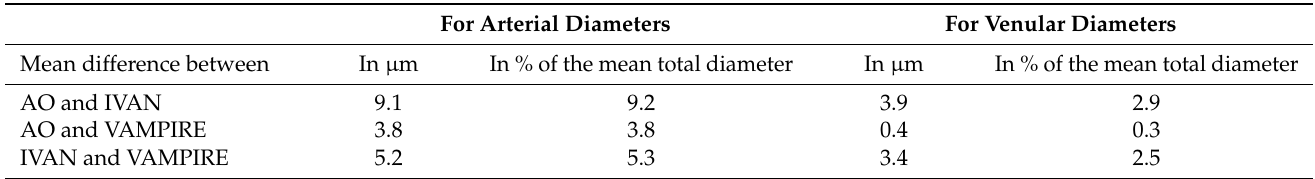
Table 1. Differences between software tools for arteries and for veins. For Arterial Diameters For Venular Diameters Mean difference between In µ m In % of the mean total diameter In µ m In % of the mean total diameter AO and IVAN 9.1 9.2 3.9 2.9 AO and VAMPIRE 3.8 3.8 0.4 0.3 IVAN and VAMPIRE 5.2 5.3 3.4